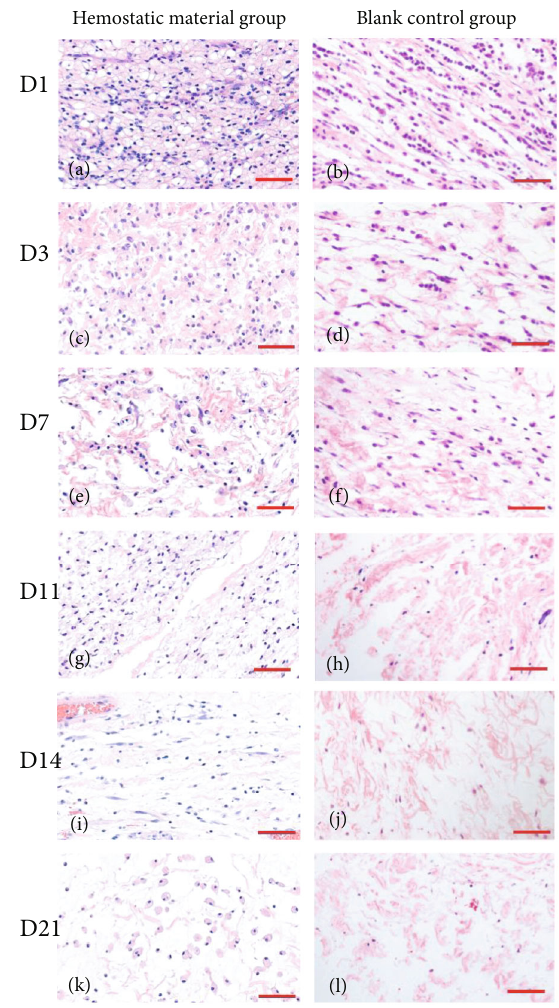
Figure 5: Histological evaluation of implantation in rats. Table 1: Hemostasis time and amount of blood loss in rat liver bleeding wound model treated with di ff erent hemostatic materials. ∗ P < 0 : 05